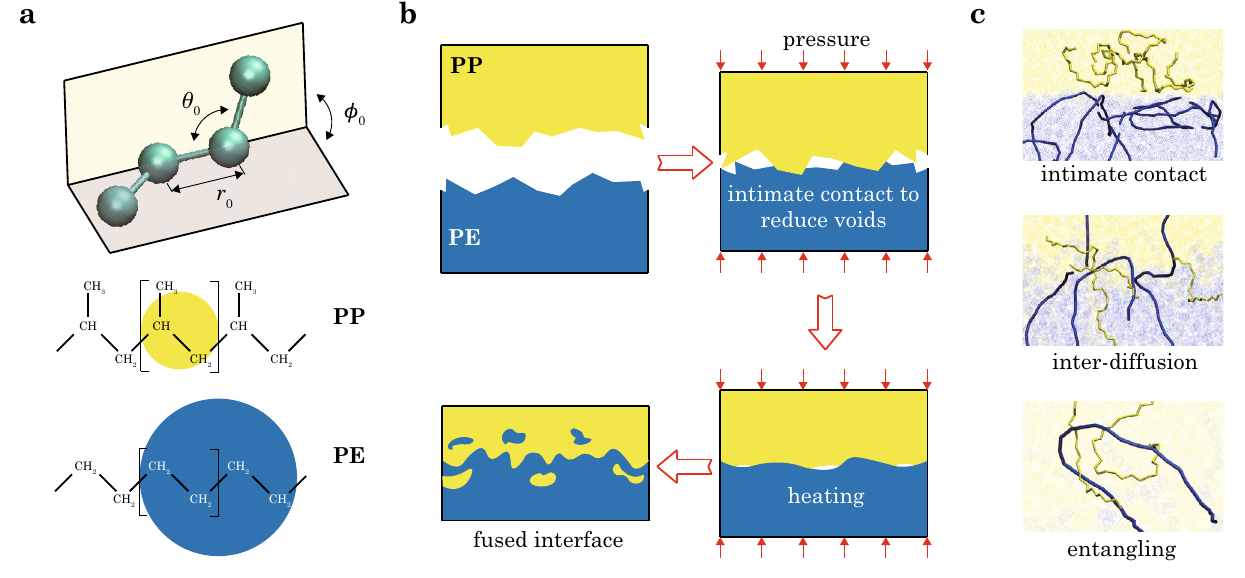
Figure 1. ( a ) Coarse-grained models of PE and PP. ( b ) Physical processes in heat fusion: ( c ), (1) intimate contact, (2) inter-diffusion, and (3)